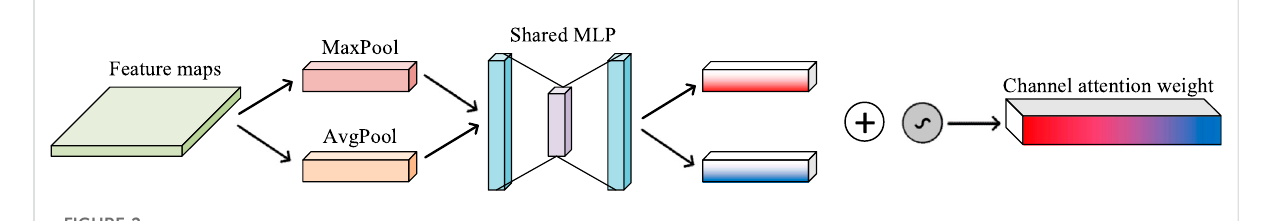
FIGURE 2 Schematic diagram of channel attention